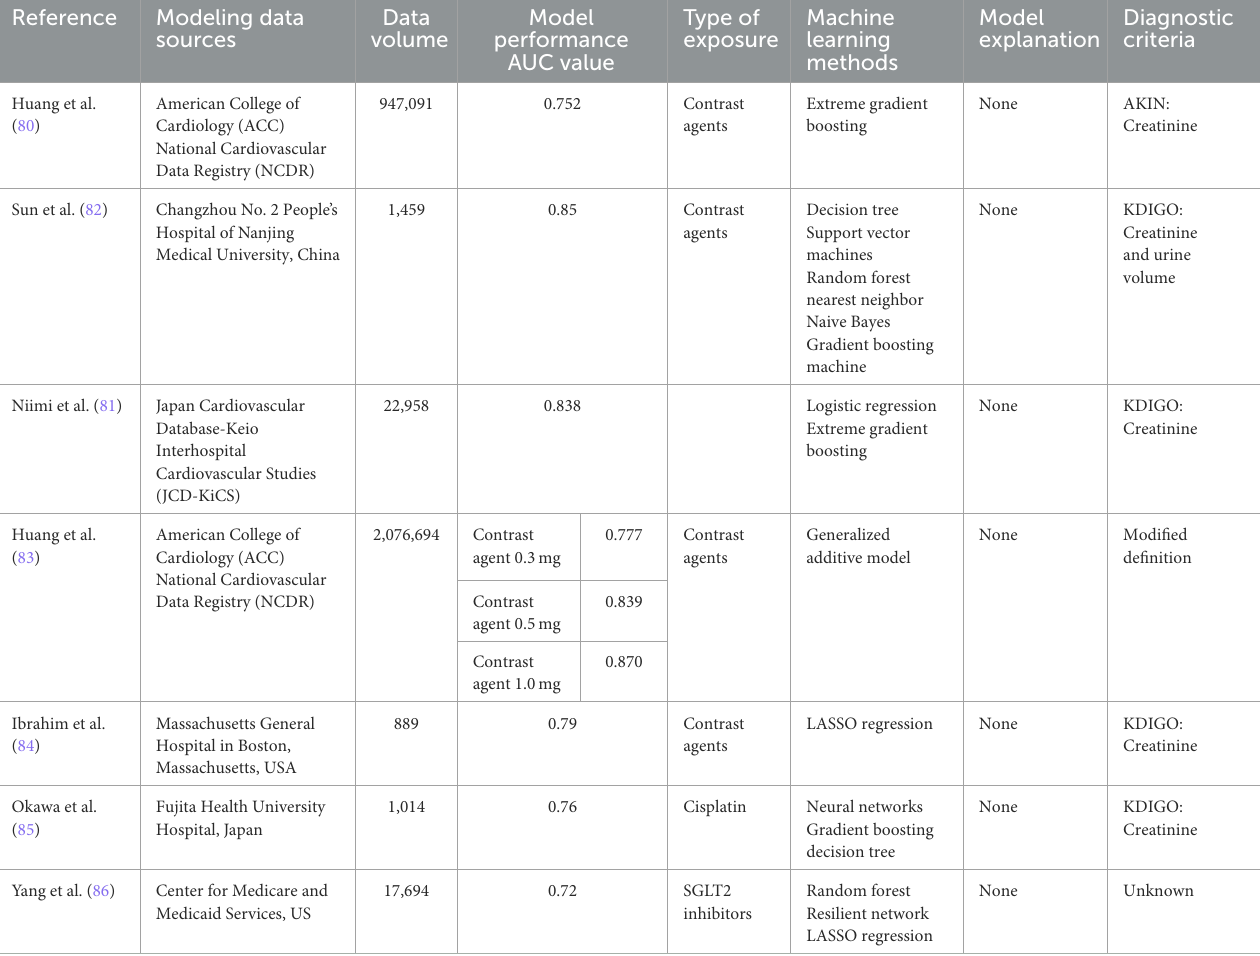
TABLE 6 Prediction model for AKI associated with specific nephrotoxin